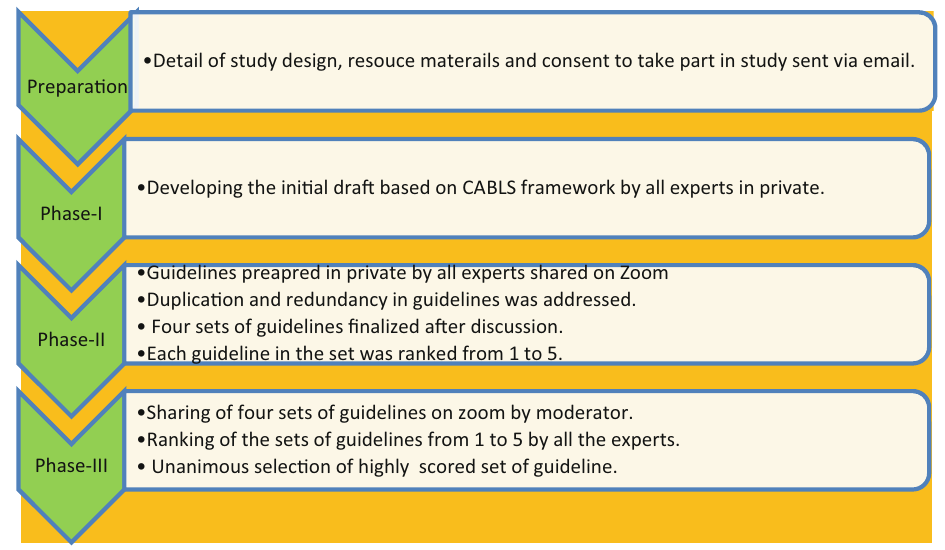
Figure 2. Nominal group technique adopted for developing the guidelines.